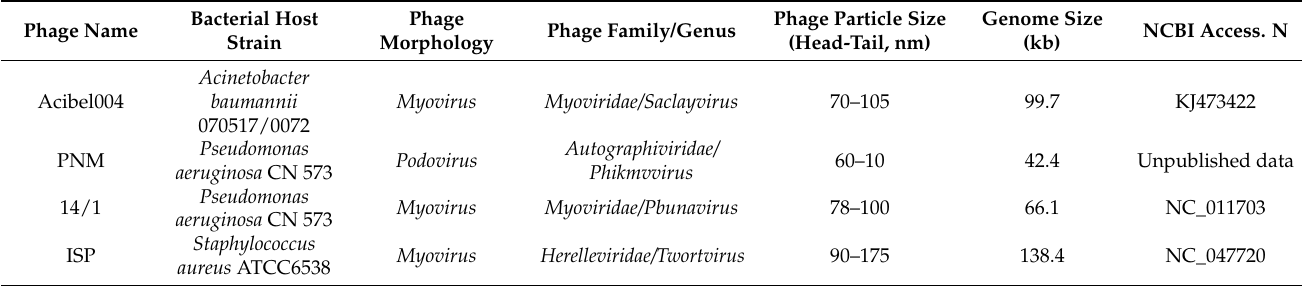
Table 1. Name, bacterial host strain, morphology, genus, particle size, genome size and National Center for Biotechnology Information (NCBI) genome accession number of each